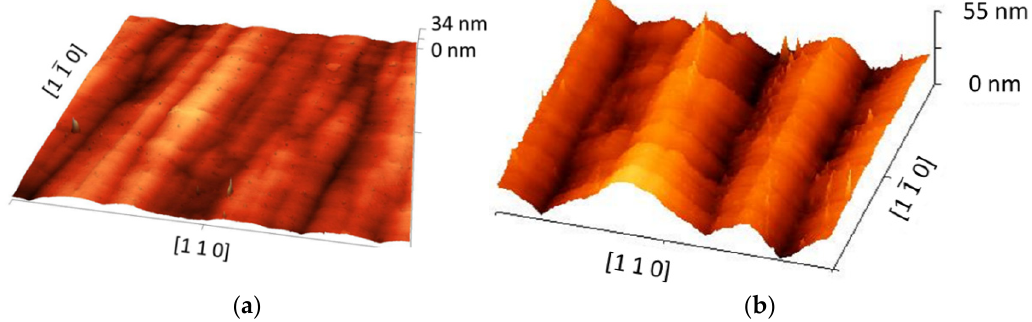
Figure 2. AFM surface topography image of ( a ) GaAsSbN and ( b ) GaAsSb layers.